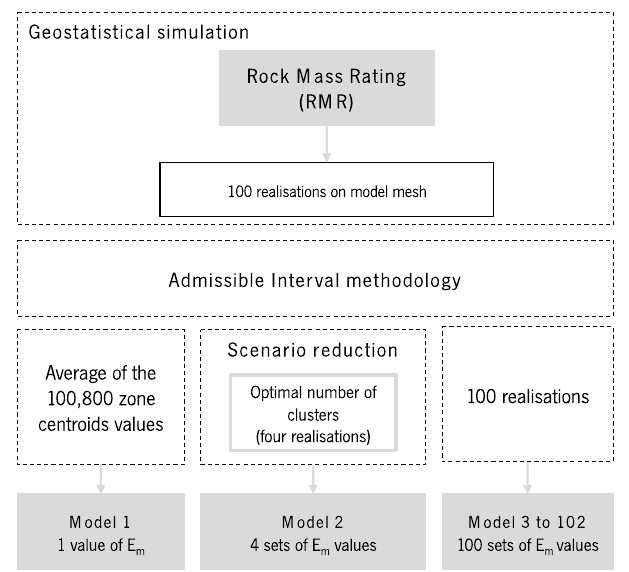
Figure 9. Workflow applied to build the different models to represent the rock mass characterisation of the rock mass using as an input the RMR system. the rock mass using as an input the RMR